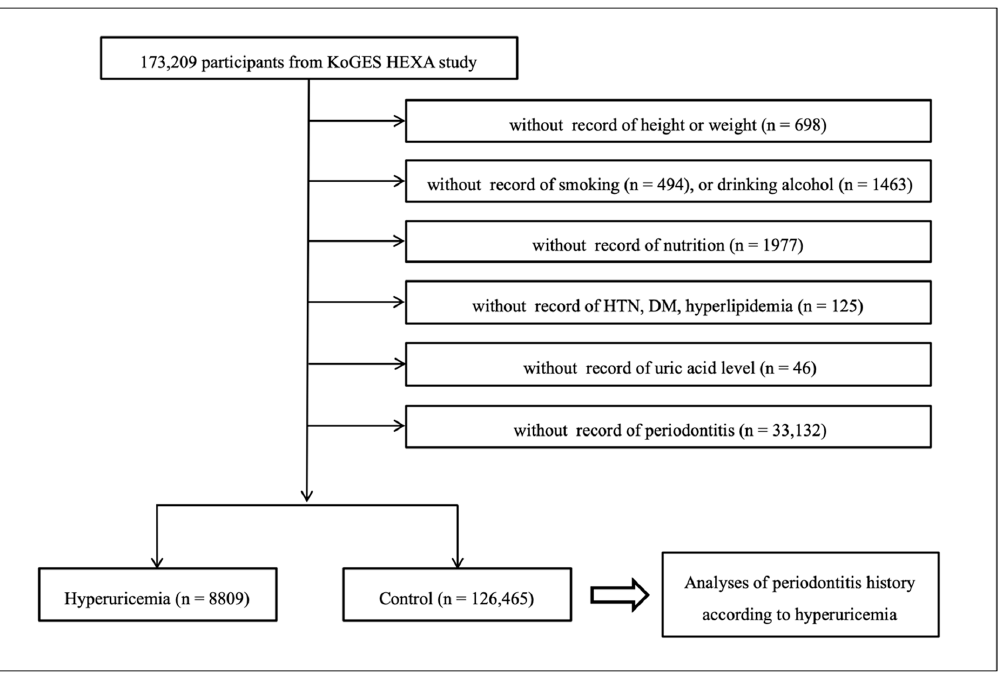
Figure 1. A schematic illustration of the participant selection process that was used in the present study. From 173,209 participants, 8809 with hyperuricemia and 126,465 controls